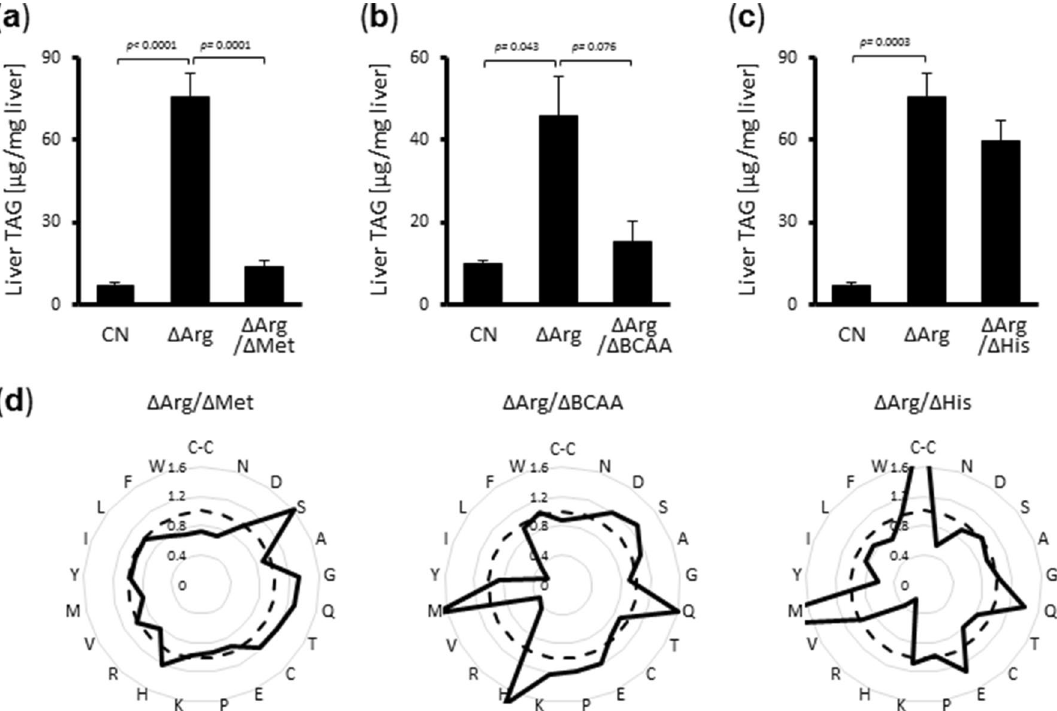
Figure 4. Perturbation of serum amino acid profile reverses arginine deficient diet-induced lipid accumulation in the liver. ( a–c ) Six-week-old male Wistar rats were fed the CN diet, ΔArg diet, both arginine and methionine deficient diet (ΔArg/ΔMet) ( a ), both arginine and BCAAs deficient diet (ΔArg/ΔBCAA) ( b ), or both arginine and histidine deficient diet (ΔArg/ΔHis) ( c ) for seven days. TAG levels in their livers. ( d ) Serum amino acid concentrations of rats shown in ( a–c ) were measured. Data of serum amino acid concentration are shown as a fold of the mean value of the CN group (dotted line), and average values of each experimental diet group (continuous line) are indicated. [bar; means ± S.E.M., (n = 4), Tukey–Kramer